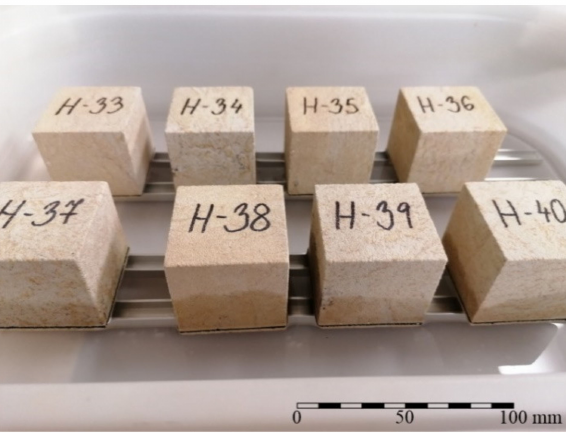
Figure 2. HS samples immersed only 3 mm deep in water during the test of WAC . Darker colour indicates the height of the saturated